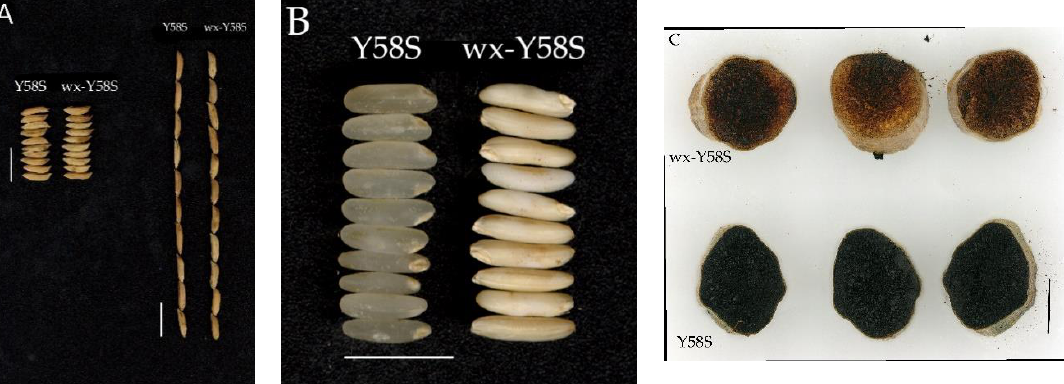
Figure 9. Comparison of rice grain phenotypes of Y58S and wx-Y58S (T 2 line W-1-B-5). ( A ) Grain; ( B ) brown rice; ( C ) iodine- stained endosperm cross sectioning. (A and B: bars = 1 cm; C: bar = 1 mm).